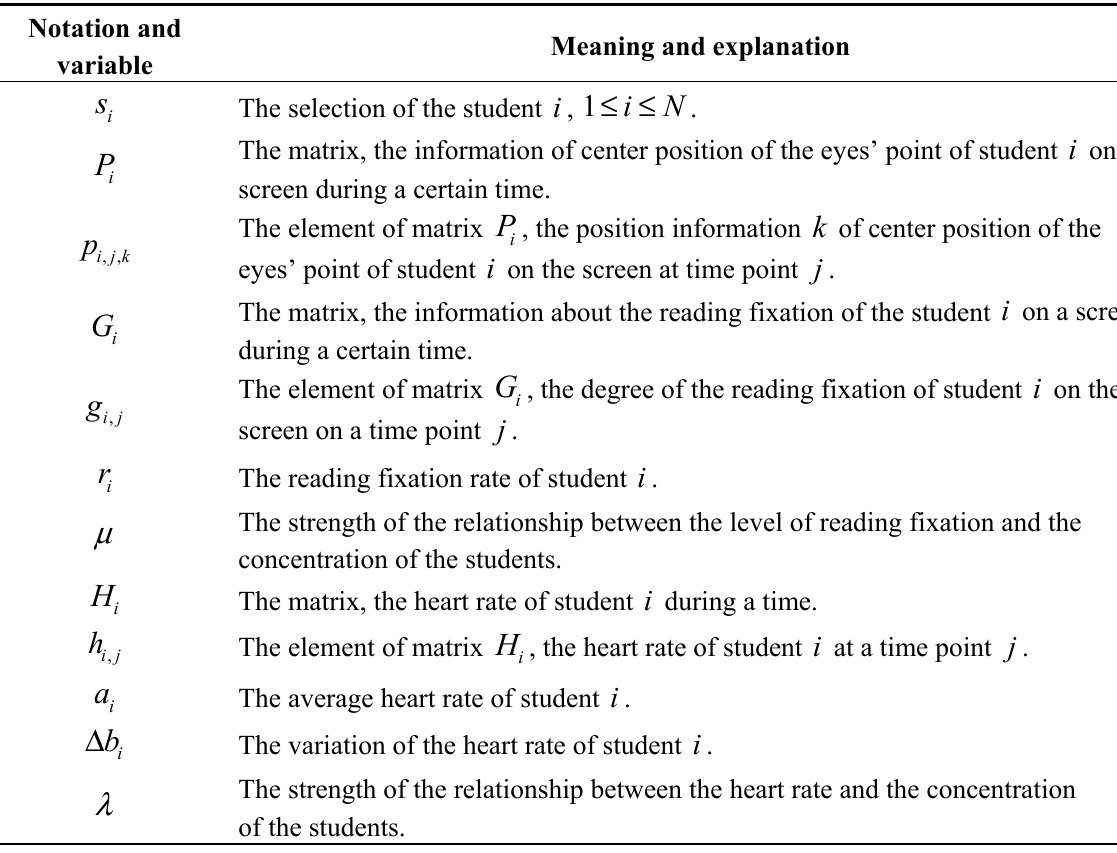
Table 1. Notations and variables used in the fitness